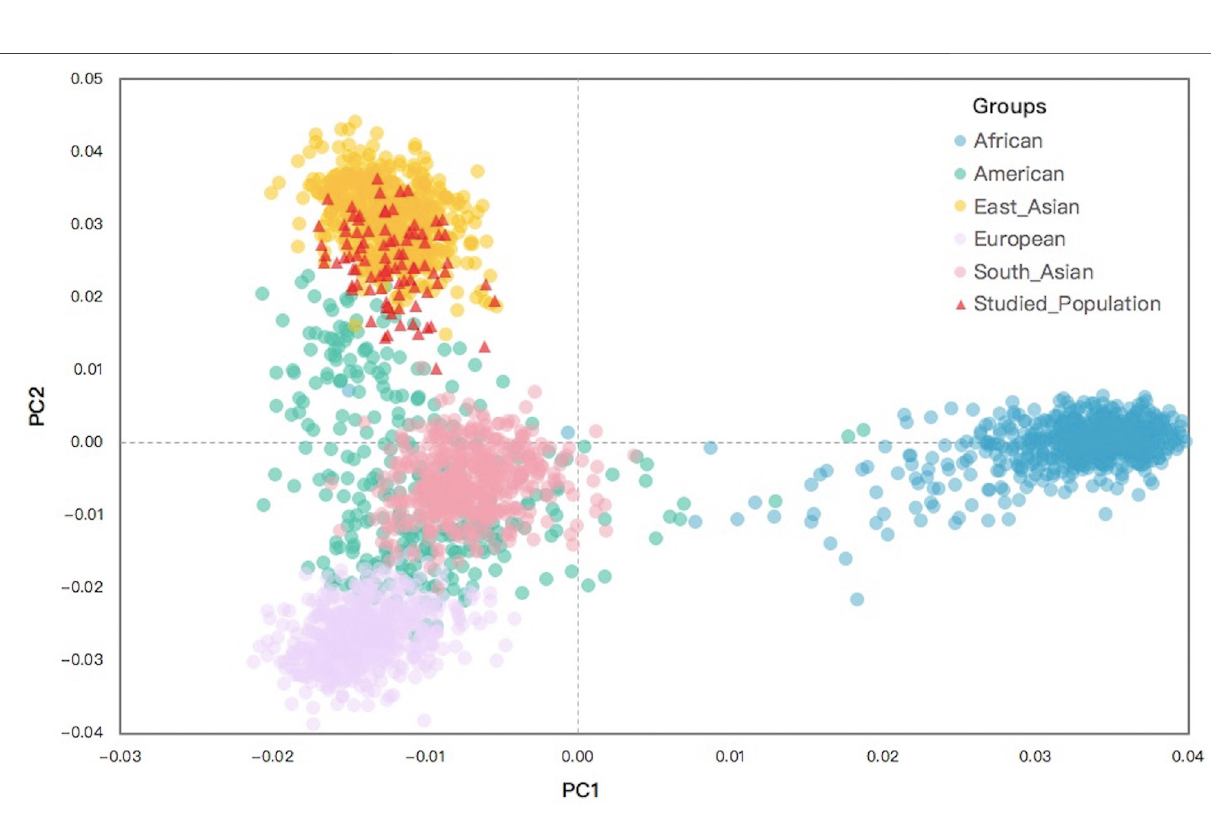
Frontiers in Genetics |